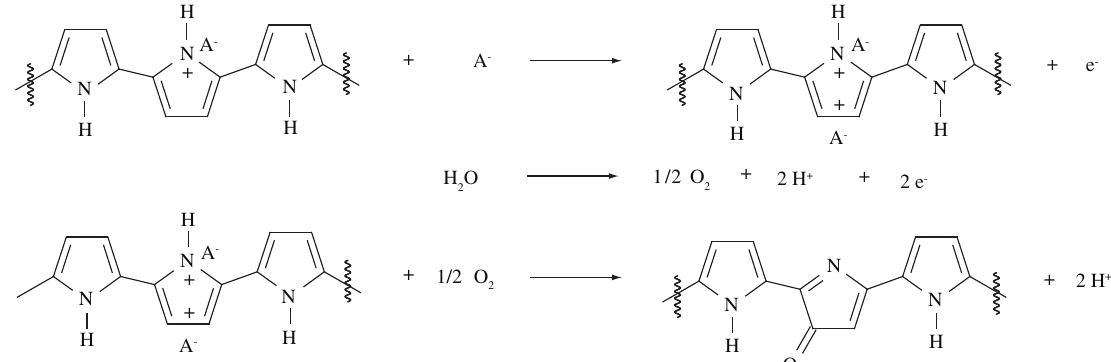
Figure 4. Reactions that occur during the overoxidation of the PPy